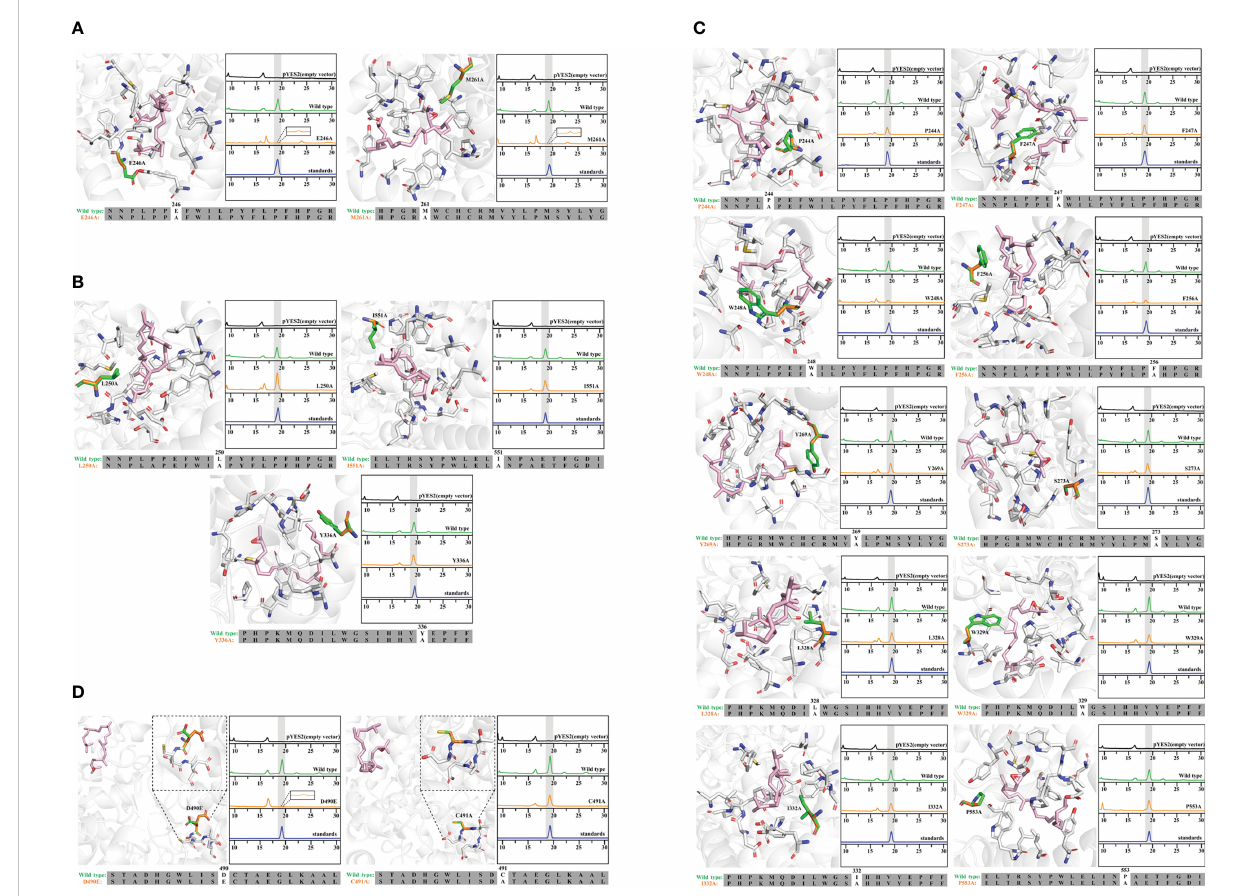
FIGURE 3 Molecular docking and site-directed mutagenesis of 2,3-oxidosqualene cyclase (HcOSC6). (A) Model docked view of HcOSC6 and 2,3-oxidosqualene (ligand); HPLC analysis of yeast extracts expressing the wild and mutant HcOSC6 (E246A, M261A). (B) Model docked view of HcOSC6 and 2,3- oxidosqualene (ligand); HPLC analysis of yeast extracts expressing the wild and mutant HcOSC6 (L250A, I551A and Y336A). (C) Model docked view of HcOSC6 and 2,3-oxidosqualene (ligand); HPLC analysis of yeast extracts expressing the wild and mutant HcOSC6 (P244A, F247A, W248A, F256A, Y269A, S273A, L328A, W329A, I332A and P553A). (D) Model docked view of HcOSC6 and 2,3-oxidosqualene (ligand); HPLC analysis of yeast extracts expressing the wild and mutant HcOSC6 (D490E and